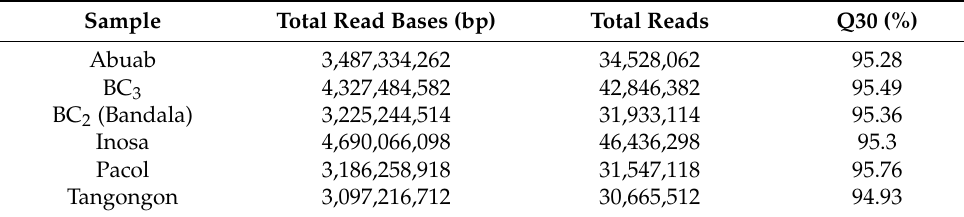
Table 3. Raw data information on the PE reads generated from sequencing of six Musa sp.